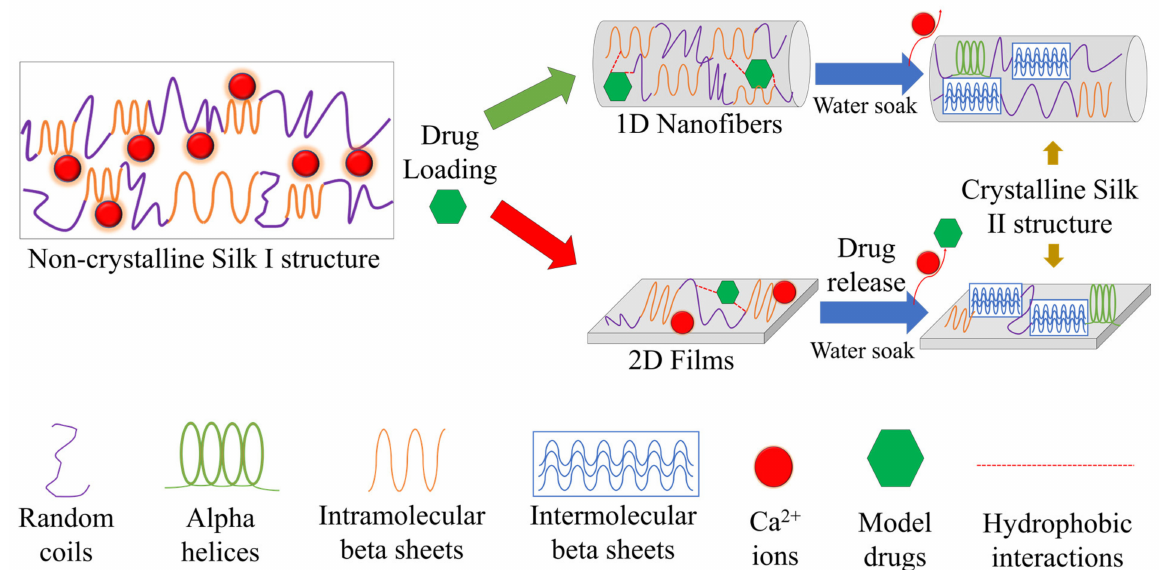
Figure 10. Conception of interaction. Porous 1D fiber networks allow for the integration of model drugs, which then influence the self-folding behavior of silk protein. In flat 2D films, model drugs are unable to interact in the same way. As a result, fibers are able to protect embedded model drugs from thermal degradation and slow the release of the molecules from its structure. In thin films, the drugs are more susceptible to thermal degradation and there is less control over their